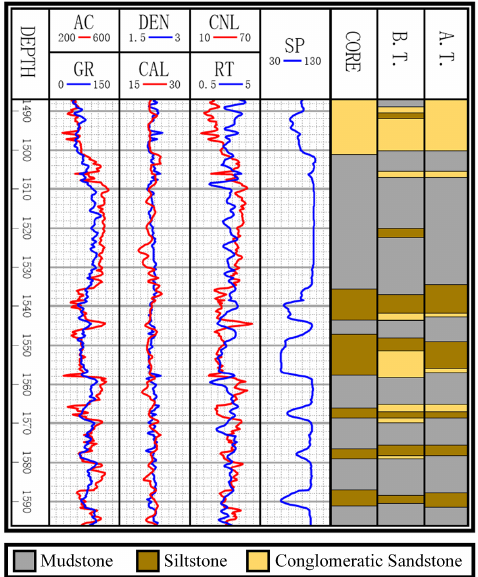
Figure 3. Logging curves, core, and classification results of B.T. (before transfer) and A.T. (after